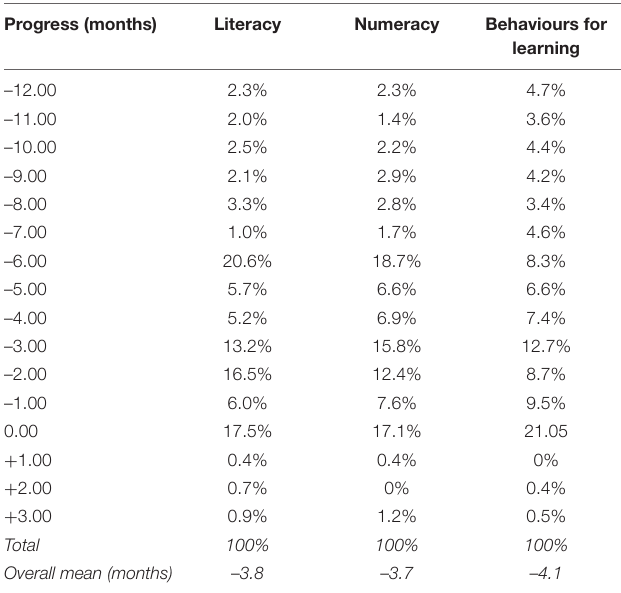
TABLE 1 | Average estimates of progress toward academic targets (May